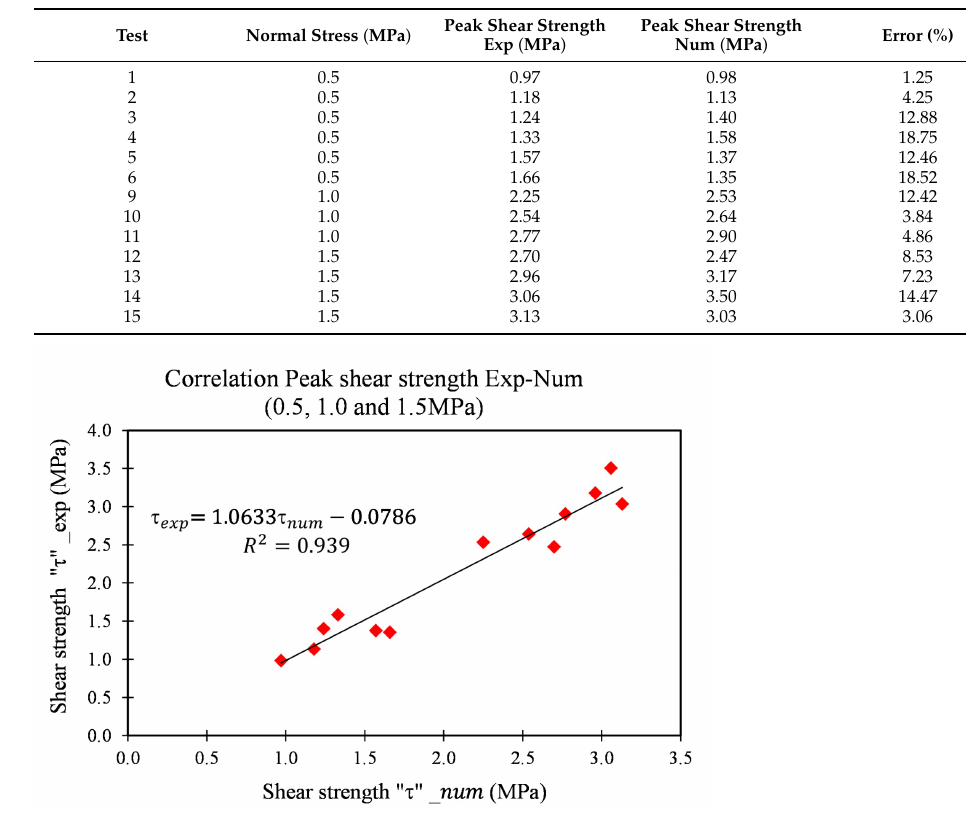
Figure 37. Peak shear strength